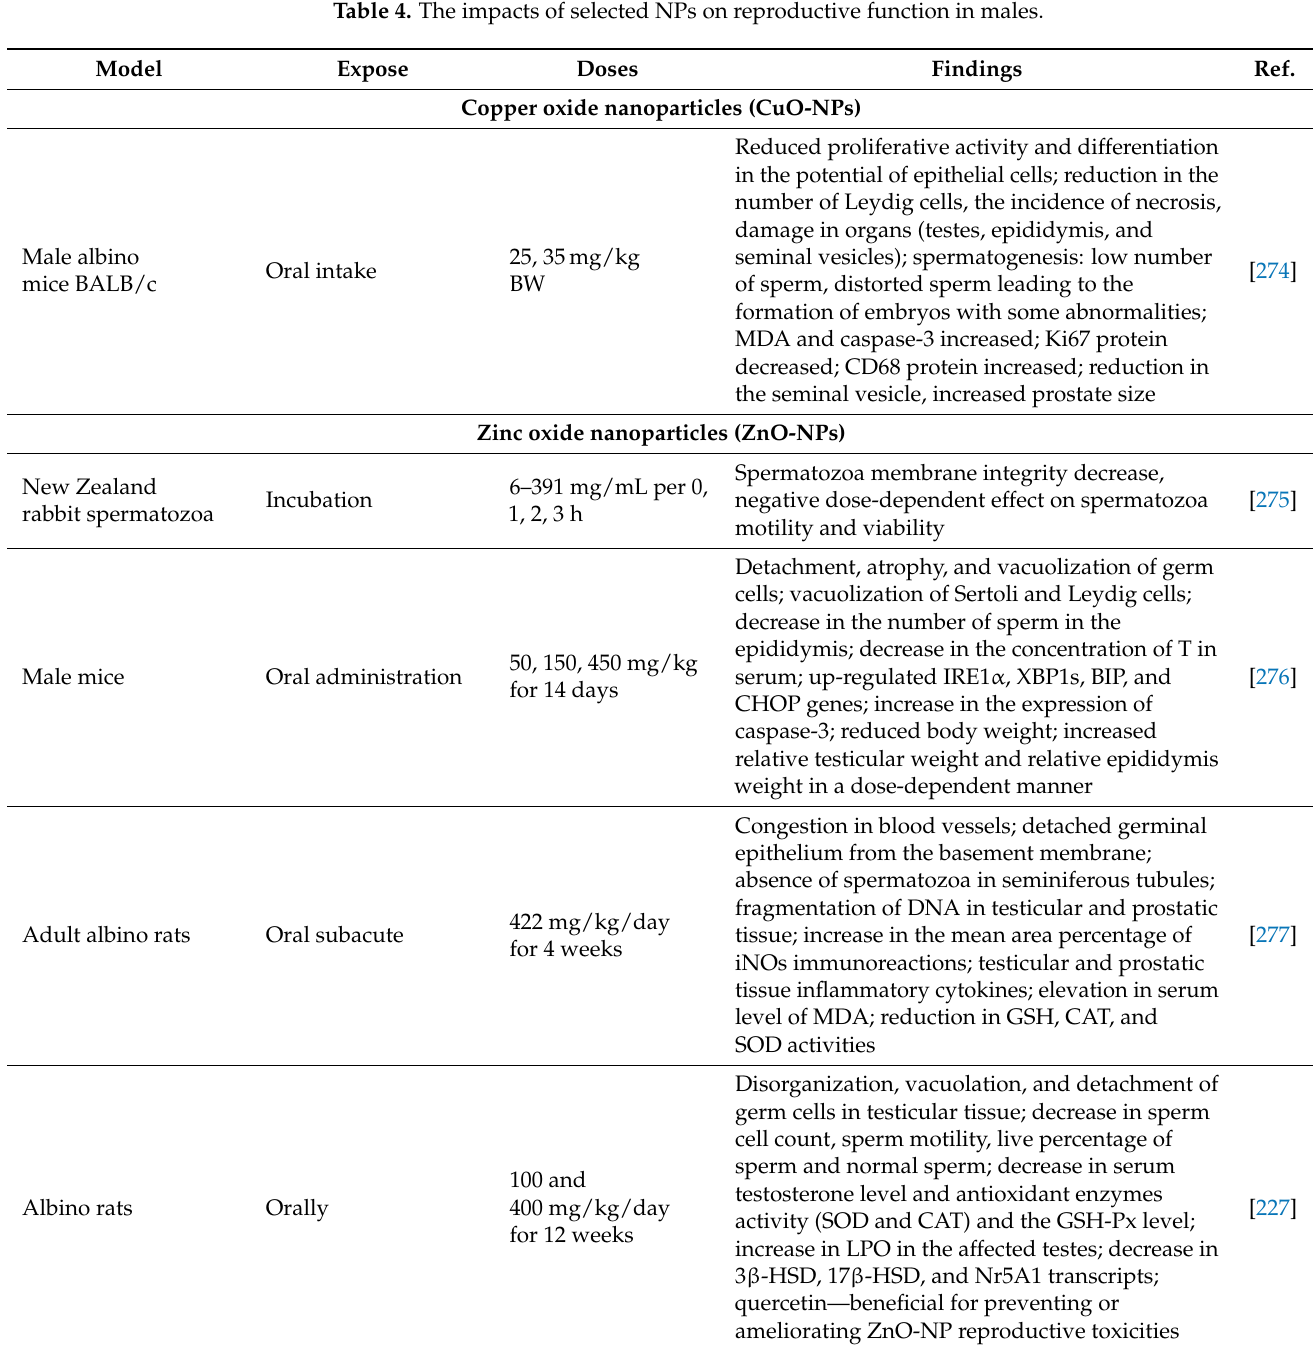
Table 4. The impacts of selected NPs on reproductive function in